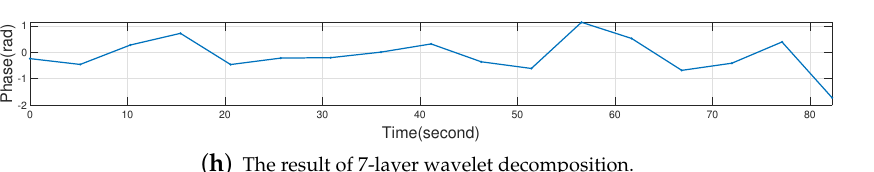
( g ) The result of 6-layer wavelet decomposition.